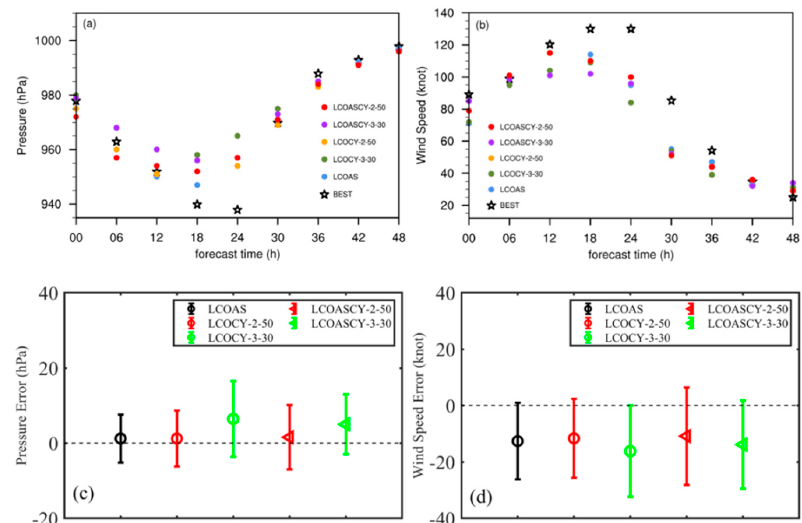
Figure 13. Same as Figure 10, except for intensity forecasts for Laura (0600 UTC on 26 August to 0600 UTC on 28 August 2020) from experiments LCOAS, LCOCY-2-50, LCOCY-3-30, LCOASCY-2-50, and LCOASCY-3-30 km, respectively.